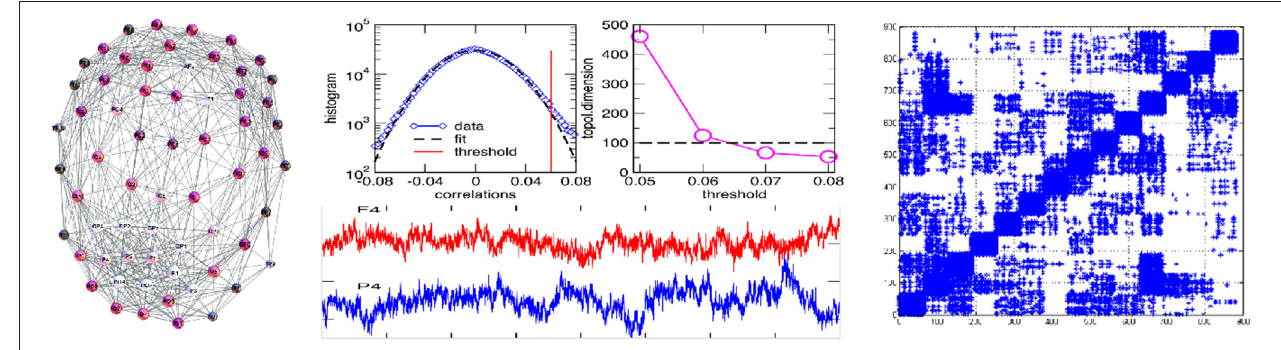
FIGURE 1 | (Left) Single-brain network (speaker S 2 ) with the labels of EEG channels; (Middle) EEG signals originating from the channels F4 in frontal, and P4 in parietal brain region (lower panel); central part of the histogram of correlations with the marked threshold, and the topological dimension of the simplicial complex vs. threshold (top panels). (Right) Multi-brain correlation matrix after filtering, see text and Tadi´c et al. [4] for more details and the